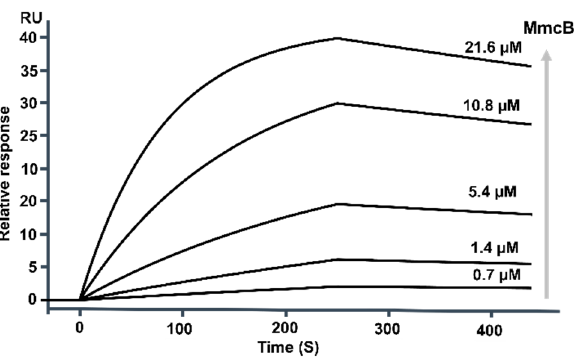
Figure 6. The determination of the interaction between MitF and MmcB by Biacore biosensor